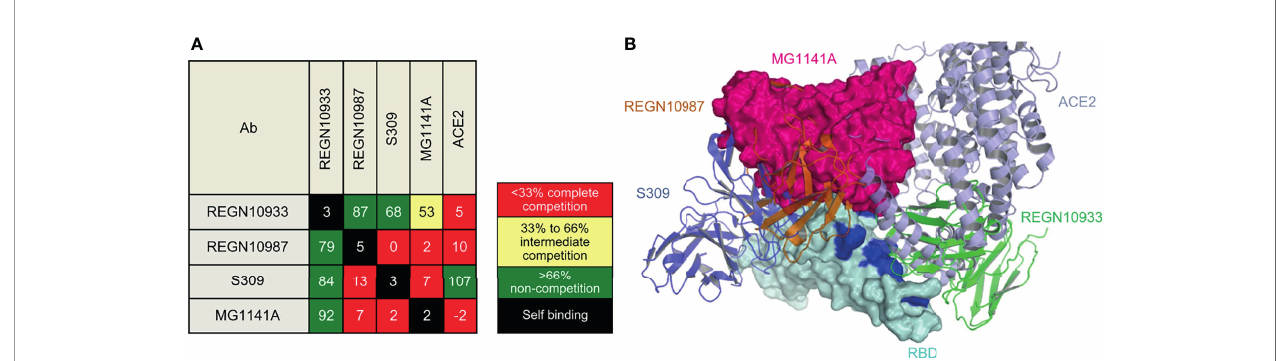
FIGURE 5 | Epitope binning of MG1141A. (A) Epitope binning heat map. Based on the reference binding, the binding level of the 2 nd antibody is shown in percentages (%) and color. The 1 st binding antibody is shown in the row, while the 2 nd binding antibody is shown in the column. The diagonal lines in white indicate that the self-binding of 1 st and 2 nd binding antibodies is identical. (B) Superposition of MG1141A scFv docking model (hot pink) on RBD structures (cyan) complexed with REGN10987, REGN10933, and S309. MG1141A scFv collided with REGN10987 (orange), S309 (tv blue), and ACE2 (light blue), but not with REGN10933 (green). The ACE2- binding region is represented by the blue